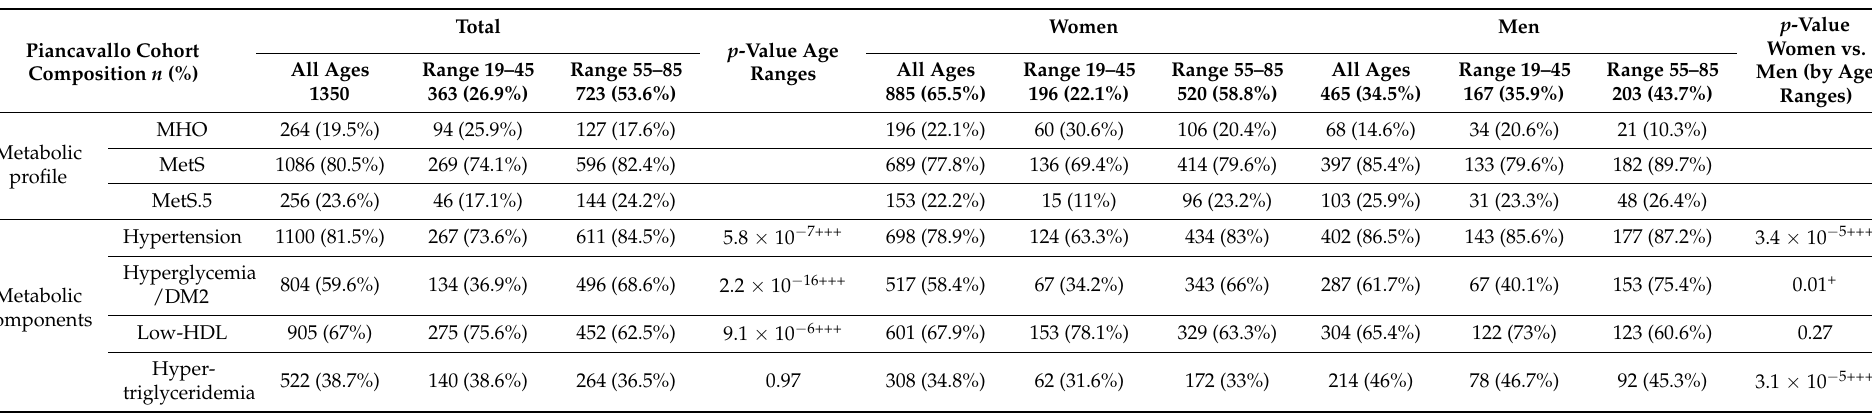
Table 2. Piancavallo cohort composition and cardiometabolic